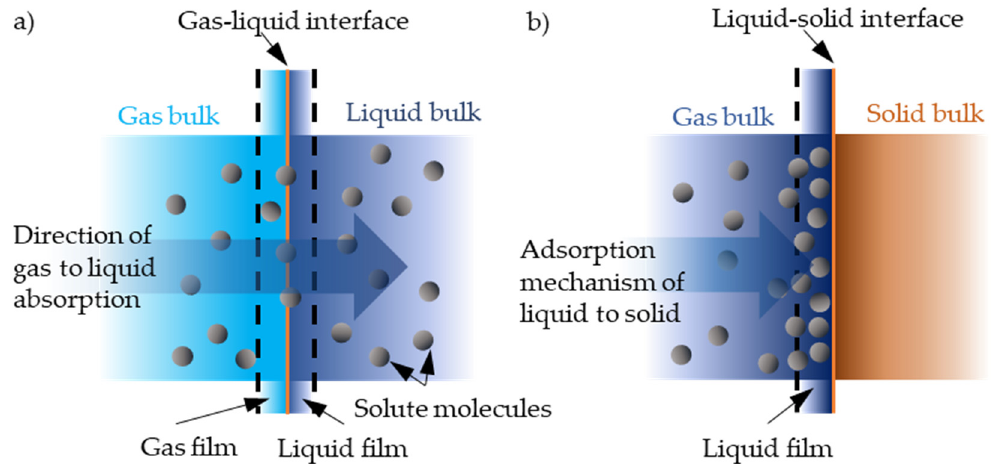
Figure 7. Gas–liquid absorption ( a ) and liquid–solid adsorption ( b ) mechanism [75]. Grey spheres represent solute molecules absorbing or adsorbing from one interface to the other.